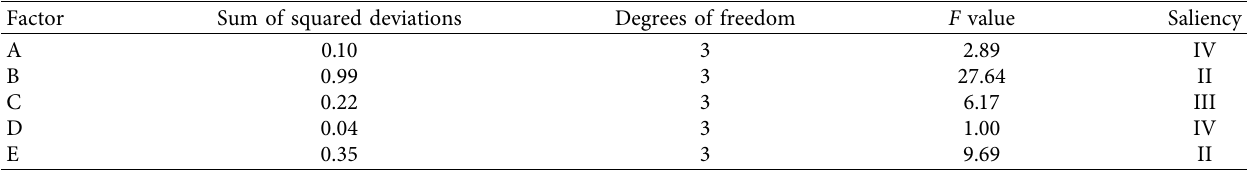
Table 4: Variance analysis of deformations in the deep rock (with depth of 2m) of the roadway